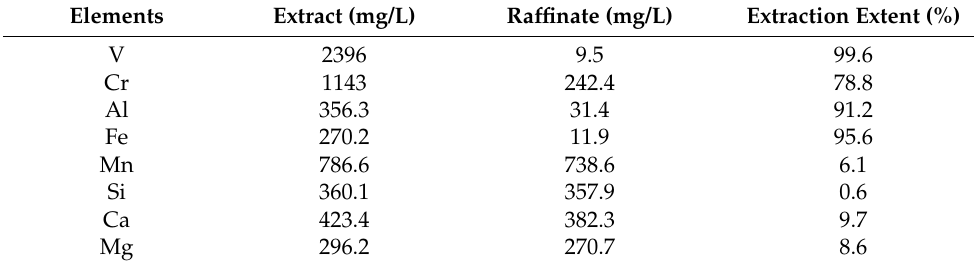
Table 3. Experimental results of three-stage countercurrent